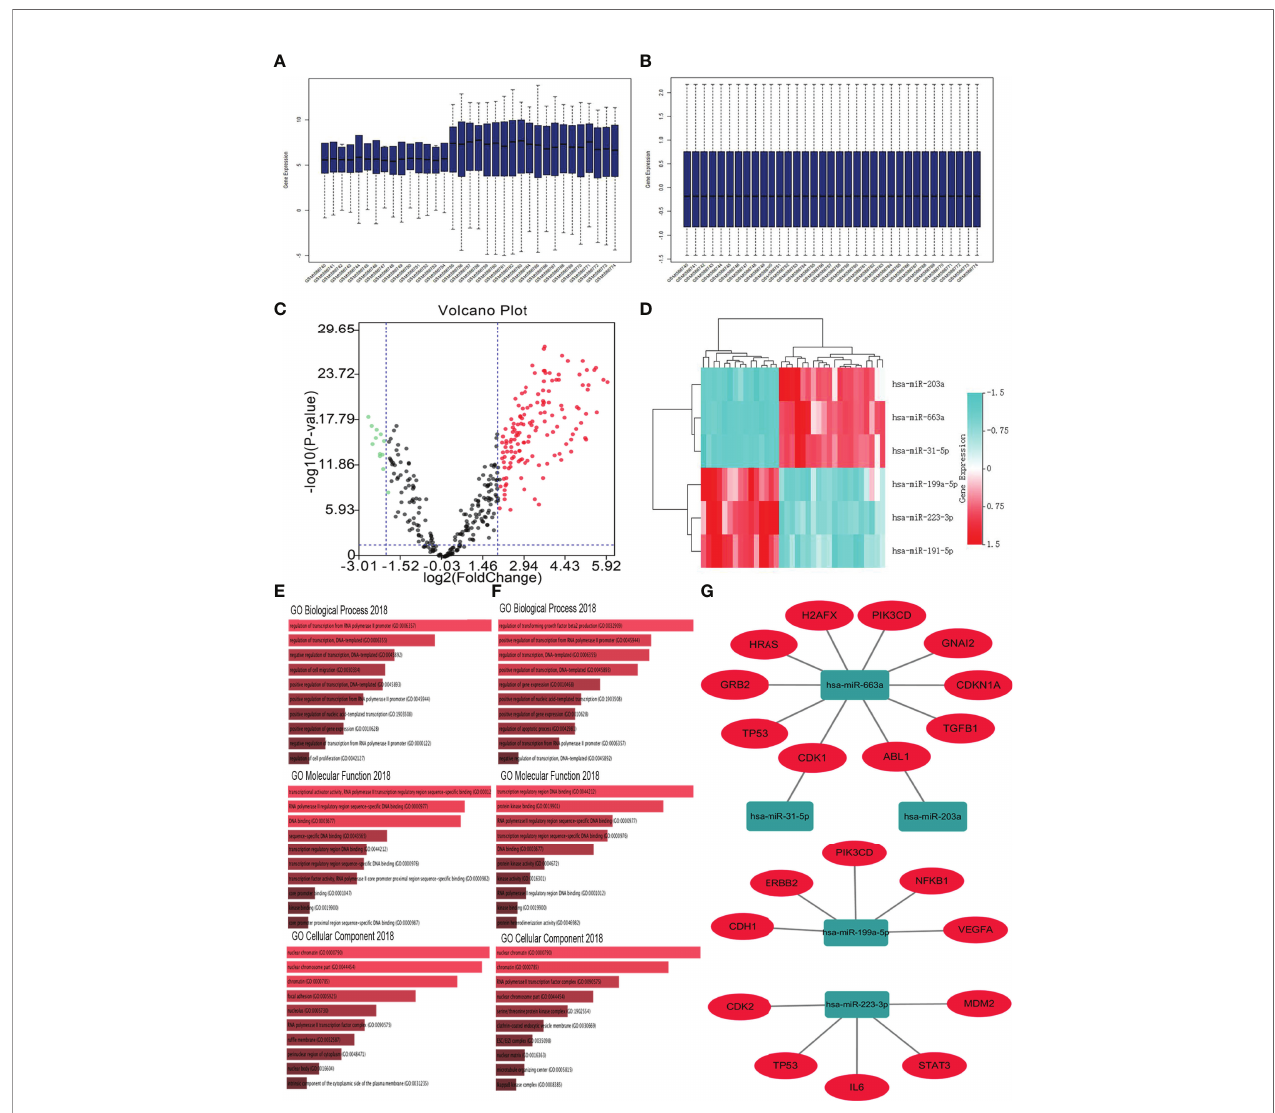
FIGURE 1 | Identi fi cation of DE − miRNAs and their target genes. (A) GSE65071 data before normalization; (B) GSE65071 data after normalization; (C) Volcano plot of the DE-miRNAs. The black dots represent miRNAs that are not differentially expressed between human osteosarcoma plasma samples and normal plasma samples, and the red dots and green dots represent the upregulated and downregulated miRNAs in human osteosarcoma samples, respectively. (D) Heat map of the top three differentially expressed miRNAs. Red represents upregulated miRNAs. Cyan represents downregulated miRNAs. (E) GO functions for the target genes of the top three upregulated miRNAs; (F) GO functions for the target genes of the top three downregulated miRNAs. (G) The regulatory network between dysregulated miRNAs and hub genes.